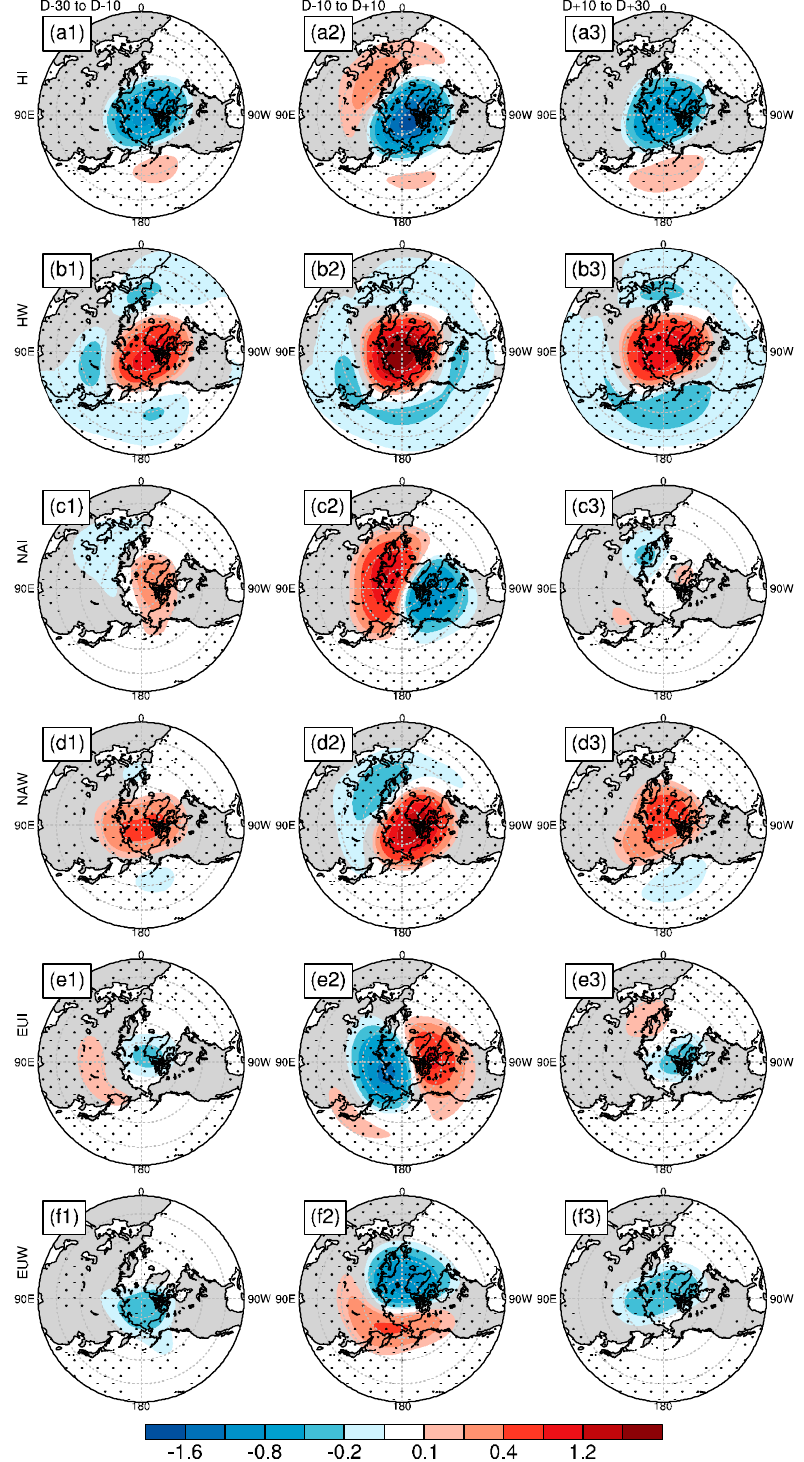
Figure 4. Composited leading/lagging evolutions of the standardized 50 hPa geopotential height anomalies (shading) during three stages from 20 to 90°N for six stratospheric Arctic vortex weather regimes based on three historical runs. ( a1 – f3 ) The clusters 1-6 are printed as HI, HW, NAI, NAW, EUI, and EUW regimes, respectively. The first column displays the average for days -30 to -10, the second column displays the average for days -10 to 10, and the third column displays the average for days 10 to 30. The dotted area indicates the composited anomalies significant at the 99% confidence level based on a two-sided Student’s t-test.